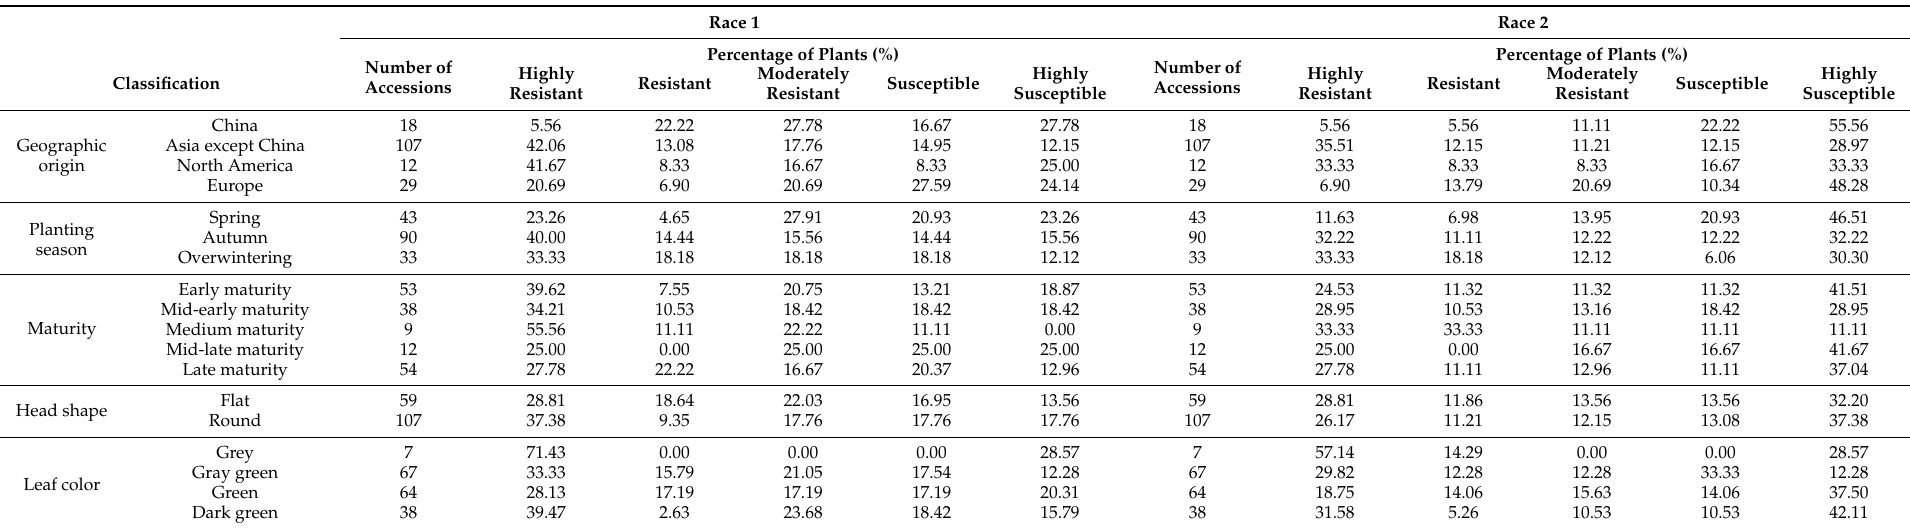
Table 1. The relationship between genotypes and